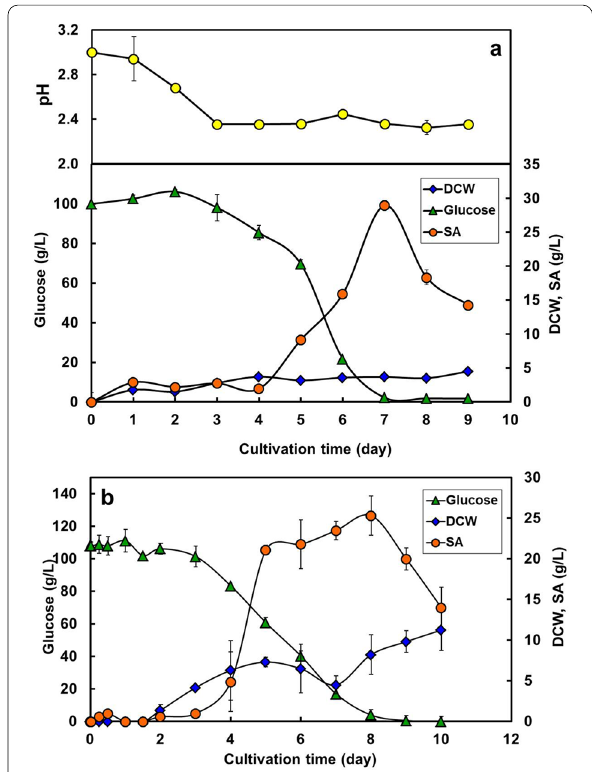
Fig. 9 Batch fermentation profiles for spiculisporic acid production with different culture equipment. a Flask culture with three baffles containing 100 mL medium with 100 g/L glucose at 28 °C for 9 days. b Bioreactor culture by an aeration stirring‑type reactor containing 1 L medium controlled at 28 °C and 700 rpm with an aeration rate of 0.5 vvm for 10 days. The cultivation was carried out with 100 g/L glucose, 4.5 g/L meat extract, and 5.0 g/L FeCl 3 . Error bars indicate standard deviations from three independent